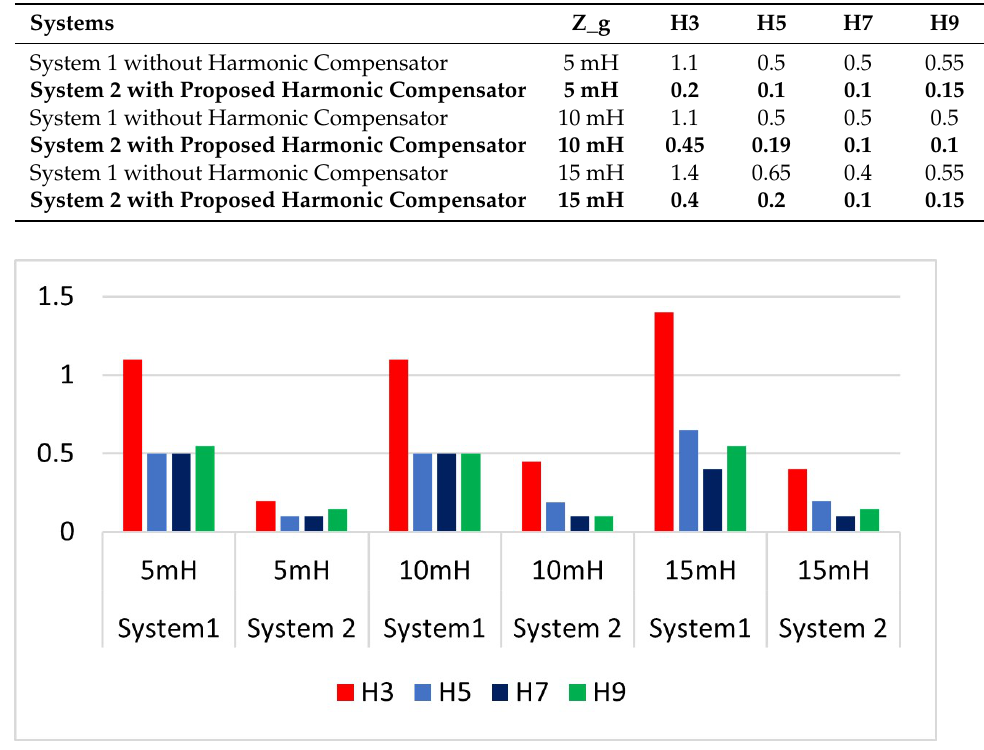
Figure 17. Bar representation of Table